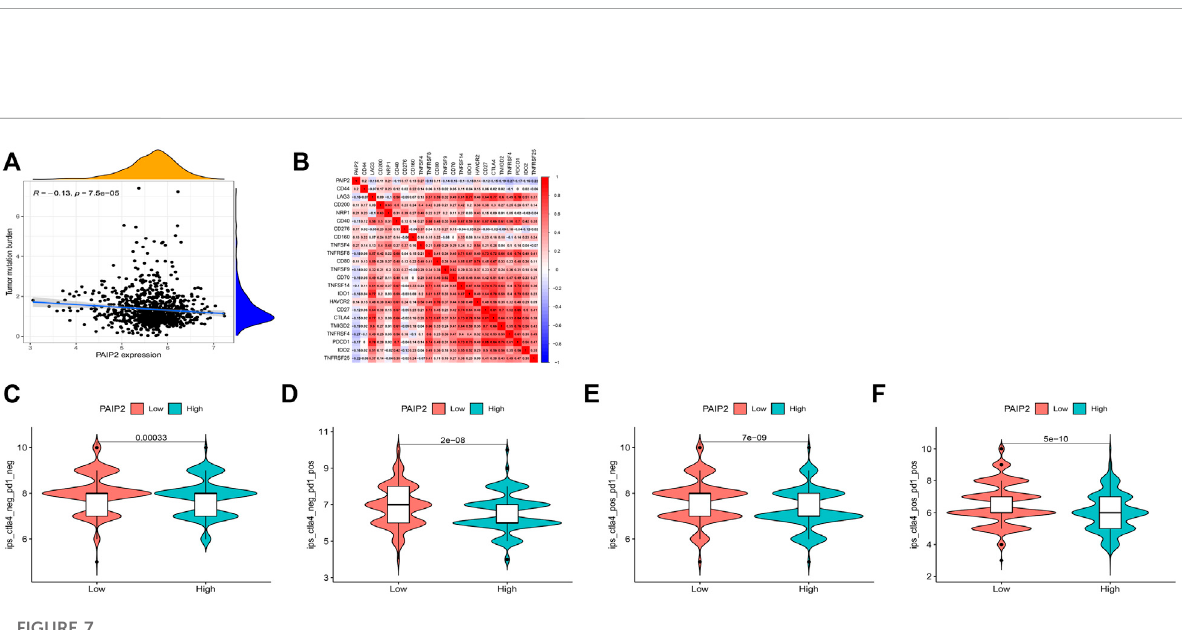
The correlation between PAIP2 and chemotherapeutic drug sensitivity Based on the pRRophetic algorithm and the limma algorithm, the IC50 of the PAIP2 high expression group and the low expression group in the GDSC database was compared. The results showed that the IC50 of 119 drugs